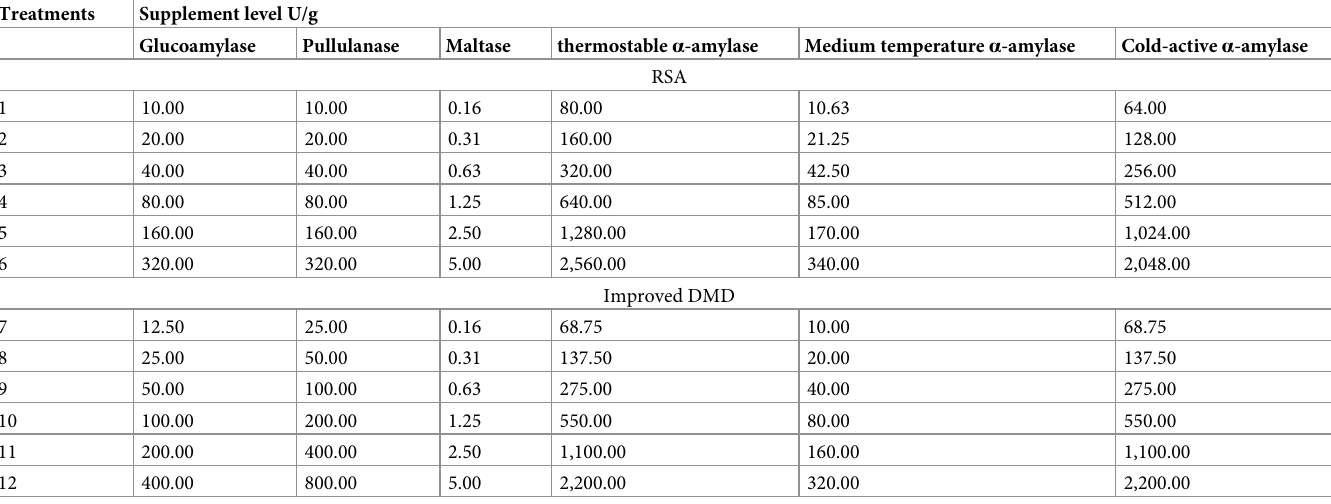
Table 2. Supplemental levels of the 6